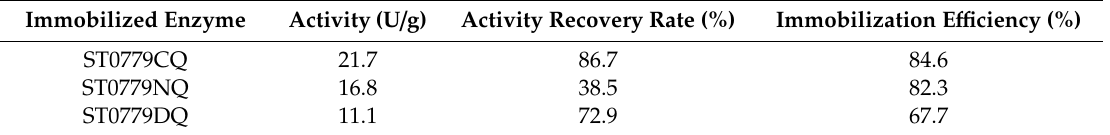
Table 2. The activity recovery rate and immobilization e ffi ciency of ST0779 immobilized by SiO 2 -Fe 3 O 4 -NP. Immobilized Enzyme Activity (U / g) Activity Recovery Rate (%)